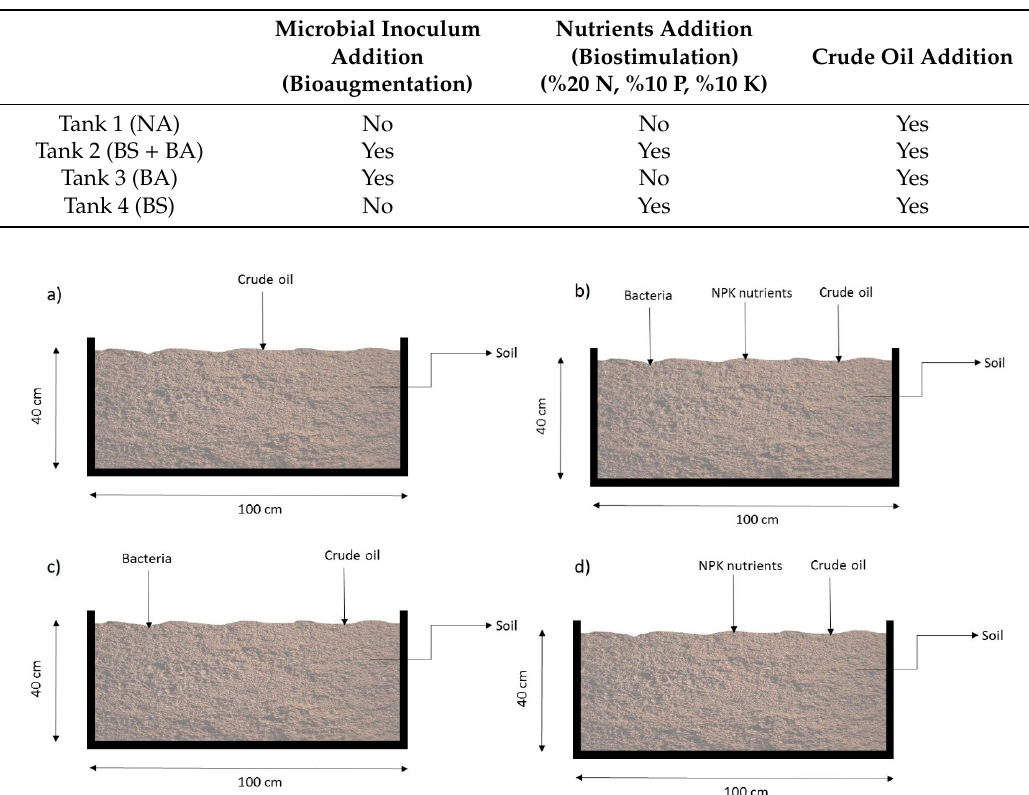
Figure 1. Schematics of soil treatment tanks ( a ) Natural attenuation (NA), ( b ) Biostimulation + Bioaugmentation (BS + BA), ( c ) Bioaugmentation (BA), ( d ) Biostimulation